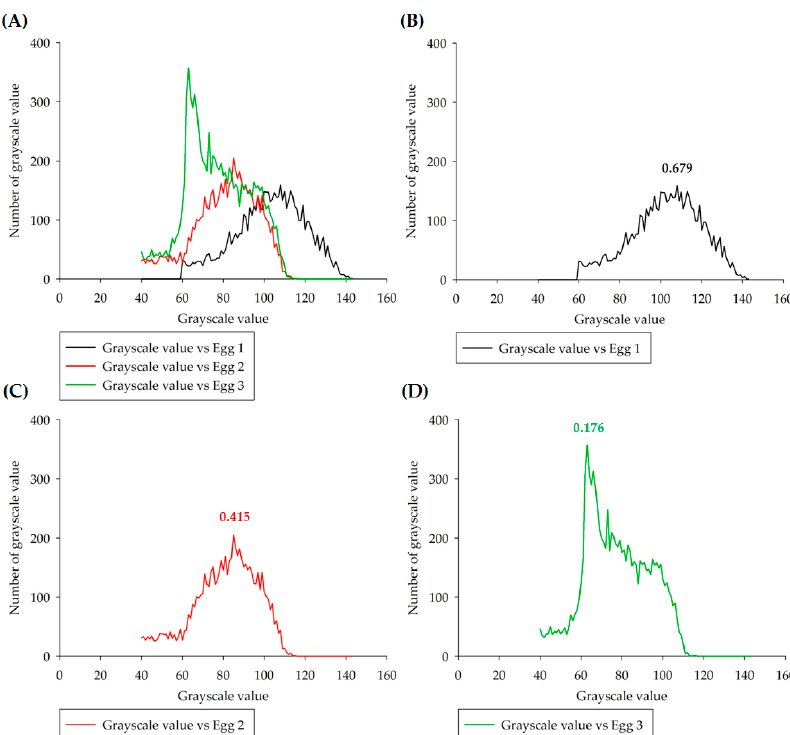
Figure 7. Analysis and statistics of the gray-scale density value distribution curve of the shells of eggs of three different qualities in the median plane direction. ( A ) Comparison of shell quality curves of eggs of three different qualities, ( B ) SO egg (Egg 1) (black line), ( C ) GO egg (Egg 2) (red line), and ( D ) CO egg (Egg 3) (green line). Appl. Sci. 2021 , 11 , x FOR PEER REVIEW Figure 8A is a comparison diagram of the shell quality curves of eggs of three dif- ferent qualities in the axial plane direction. The results show an overlap of the distribu- tion curves, where the peak gray-scale density of the shell is 0.736 in Figure 8B, 0.831 in Figure 8C, and 0.708 in Figure 8D. The dispersion curve diagram cannot clearly show the analysis results of the comparison of the shell quality.